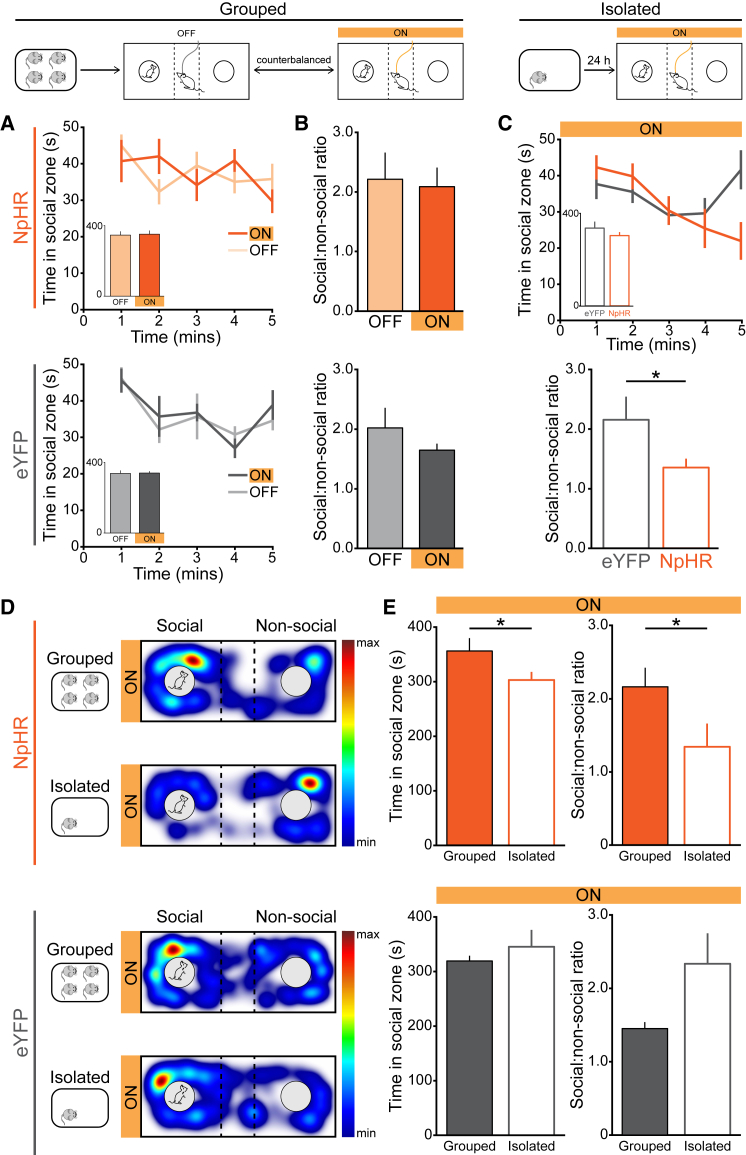
Optical Inhibition of DRN DA Neurons Reduces Social Preference Only Following Isolation(A) Group-housed TH::Cre mice expressing NpHR (upper panels) or eYFP (lower panels) in the DRN, in a Cre-dependent manner, were assessed in the three-chamber sociability task. Time spent in the social zone across the first 5 min of the task (inset shows total time) and (B) the social:non-social ratio. Optical inhibition did not produce a detectable difference in the total time spent in the social zone (NpHR, inset, paired t test: t12 = 0.1778 p = 0.8619, n = 13; eYFP: t9 = 0.1788, p = 0.8621, n = 10) or the social:non-social ratio (NpHR, paired t test: t12 = 0.2414, p = 0.8133, n = 13; eYFP: t9 = 1.293, p = 0.2282, n = 10).(C) Mice were isolated from their cagemates for 24 hr and then tested for sociability with optical inhibition. Time spent in the social zone by NpHR- and eYFP-expressing mice across the first 5 min (inset shows total time) and social:non-social ratio following isolation. NpHR-expressing mice spent a significantly lower proportion of time in the social zone after 24 hr of isolation compared with eYFP-expressing mice (social:non-social ratio, unpaired t test: t16 = 2.236, ∗p = 0.0400, n = 7 eYFP, 11 NpHR).(D) Representative spatial heat maps showing the location of an NpHR- (upper panels) and eYFP-expressing mouse (lower panels) in the first 5 min of the task, when group-housed and following 24 hr of isolation.(E) Time spent in the social zone and social:non-social ratio of mice tested with photoinhibition while group-housed and following social isolation. Photoinhibition in NpHR-expressing mice resulted in a significant reduction in time spent in the social zone (paired t test: t10 = 2.740, ∗p = 0.0208, n = 11) and social:non-social ratio (paired t test: t10 = 2.239, p = ∗0.0491, n = 11) following social isolation, compared to when group-housed.Data are represented as mean ± SEM. See also Figure S6.